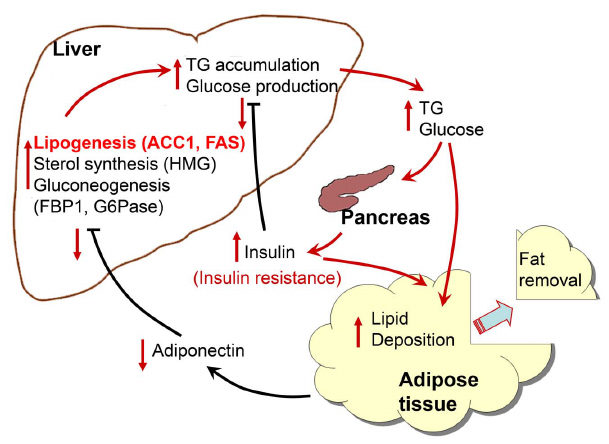
Figure 6. A proposed scheme of the molecular basis of the impact of lipectomy in obese rats. Fat removal in obese rats caused a reduced level of circulating adiponectin that would release its inhibition on the hepatic anabolic pathways, especially lipogenesis, and subsequently enhanced TG and glucose productions. The increase level of blood glucose stimulated the secretion of insulin and augmented insulin resistance in the long run that would further remove the inhibitory action of insulin on glucose production. These short term metabolic changes in response to the condition of an immediate shortage of energy storage ultimately led to long-term excess lipid deposition. Red arrows represent the events in response to fat removal.